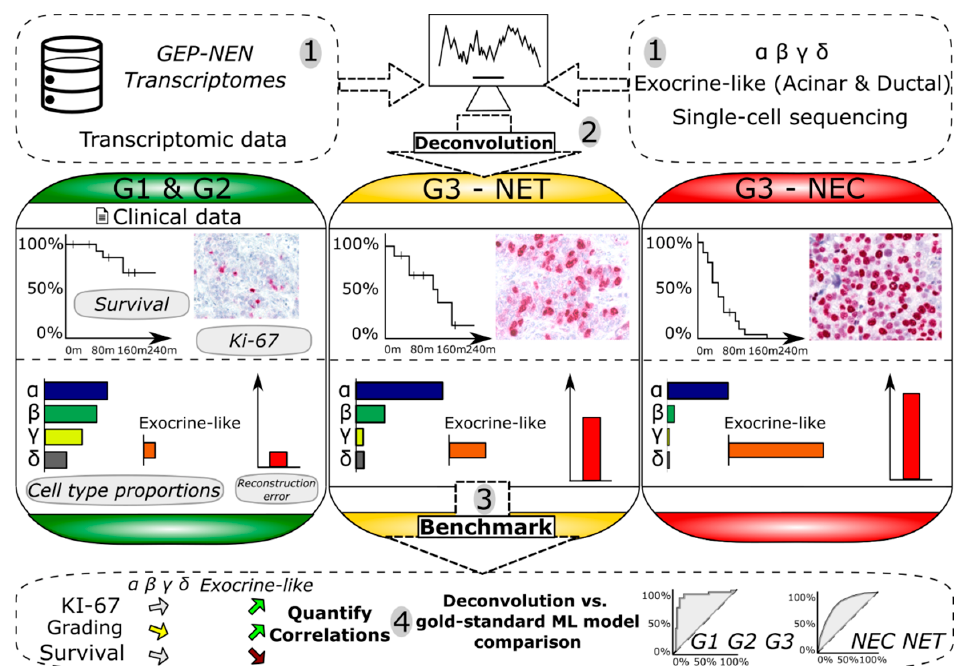
Figure 1. Overview of the framework which predicts clinically relevant panNEN and GEP-NEN characteristics based on a transcriptomic deconvolution. 1: Deconvolution algorithms are trained on different scRNA-based cell type datasets of healthy origin: endocrine-only and endocrine exocrine- like mixed. 2: The deconvolution p-values, cell type proportion predictions, and technical feature values are quantified for pancreatic and non-pancreatic NENs, different grading, and NEC and NET status. 3: Training of secondary ML models on the deconvolution results to predict clinically relevant properties of NENs from different benchmark datasets. 4: The deconvolution-trained ML model’s predictive power is compared to a baseline model. Additionally, the correlations between the cell type predictions with NEN grading, MKI67 , and the survival time is